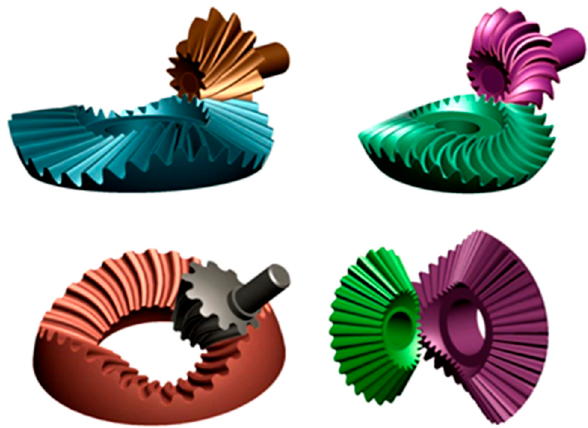
Figure 3. Examples of non-circular bevel gears with free-form tooth profiles and curvilinear teeth in their lengthwise direction